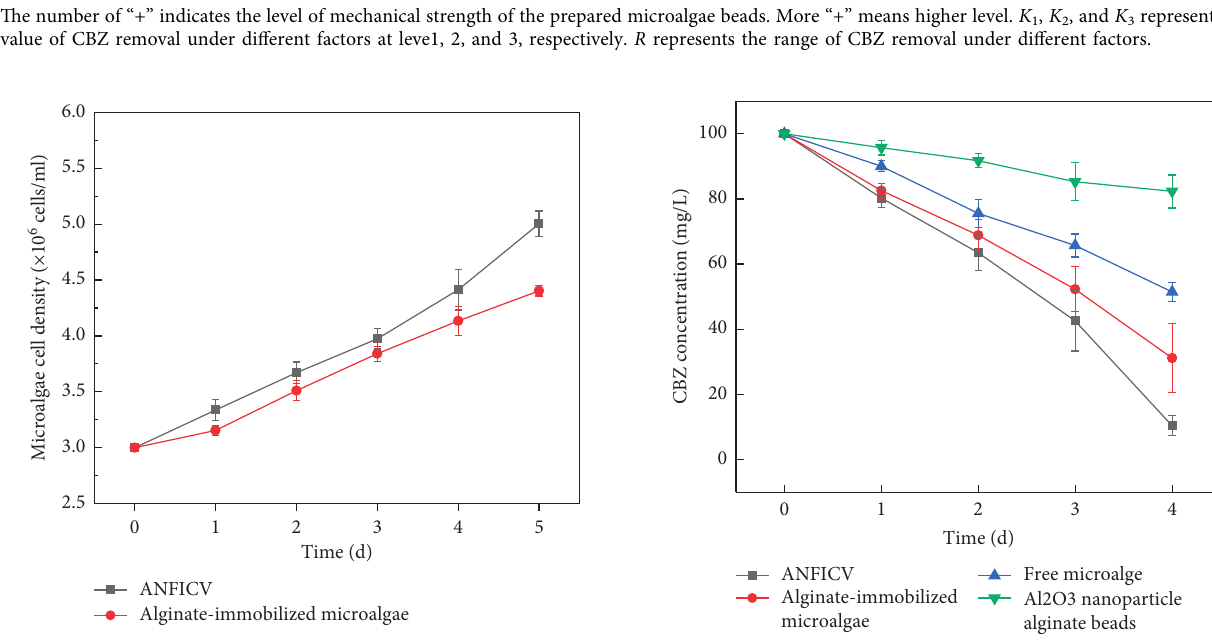
Figure 2: The concentration of CBZ with time under different treatment proposals.